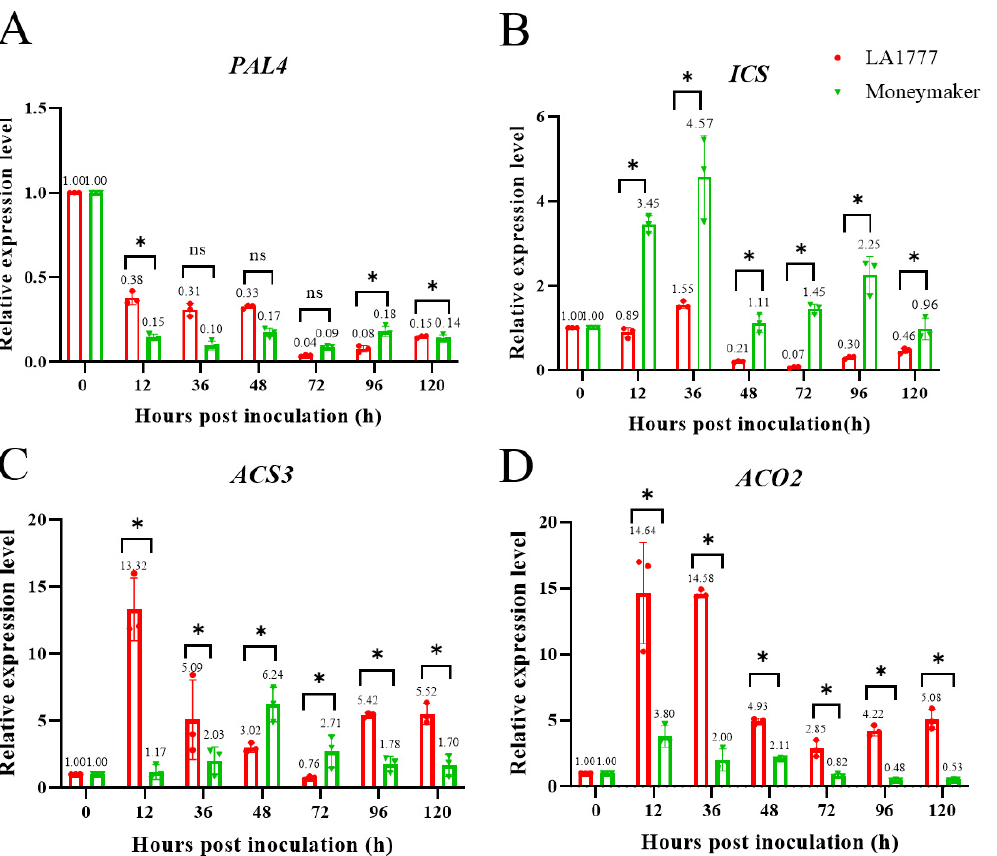
Figure 8. The expression of PAL4 and ICS are suppressed, but the expression of ACS3 and ACO2 are activated in wild tomato LA1777 under On -lz infection. In the figure, the red legend represents the data from tomato LA1777 seedlings and the green legend represents the data from cultivar tomato MM. ( A ) The expression level of PAL4 . ( B ) The expression level of ICS . ( C ) The expression level of ACS3. ( D ) The expression level of ACO2 . The asterisk indicates statistically significant differences and ‘ns’ indicates no statistically significant differences at level α = 0.05 with Student’s t -test between wild tomato LA1777 and cultivar tomato MM seedlings.